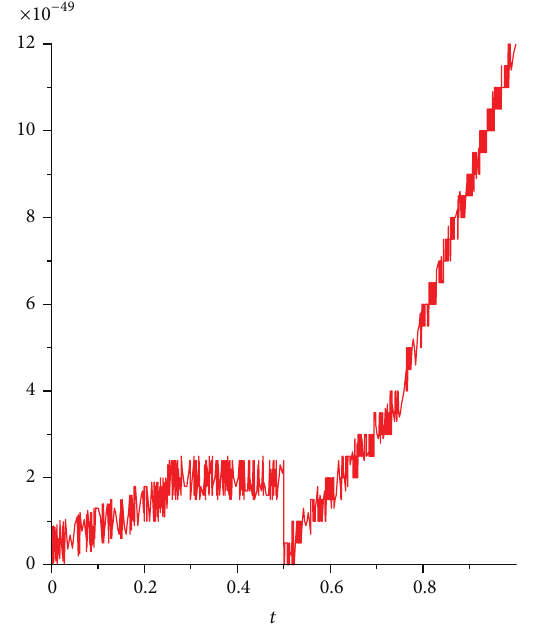
Figure 5: Approximate and exact solutions for 𝛼 = 2 for Example 5.